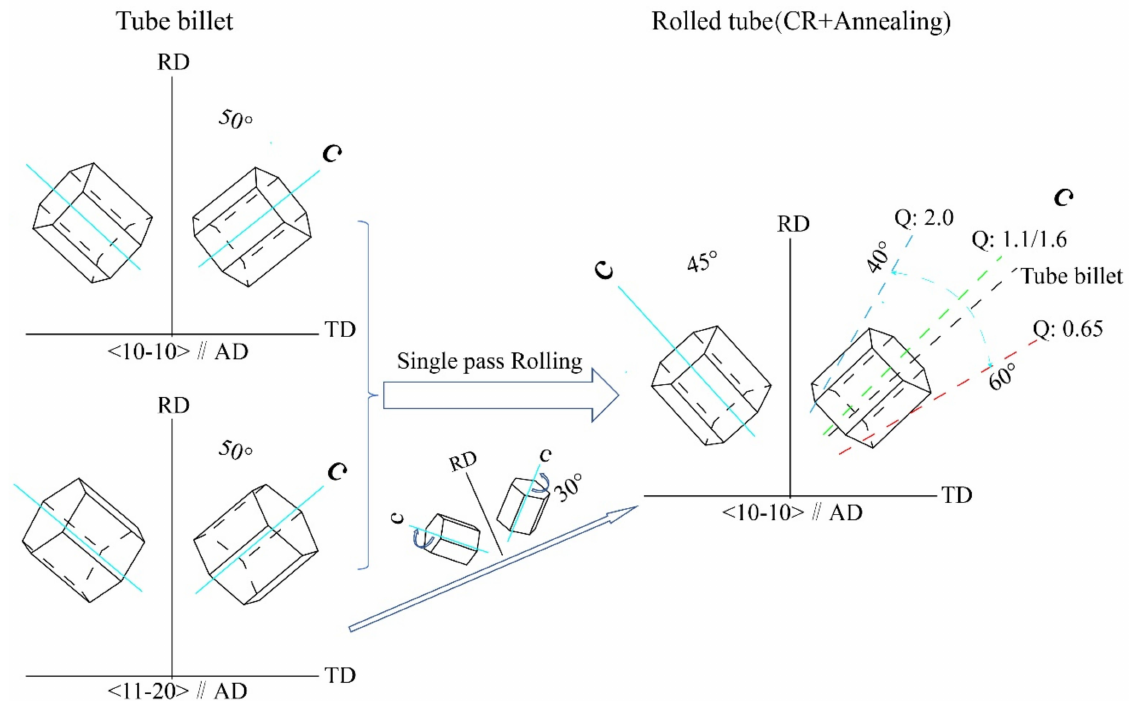
Figure 4. {0001} texture grain evolution